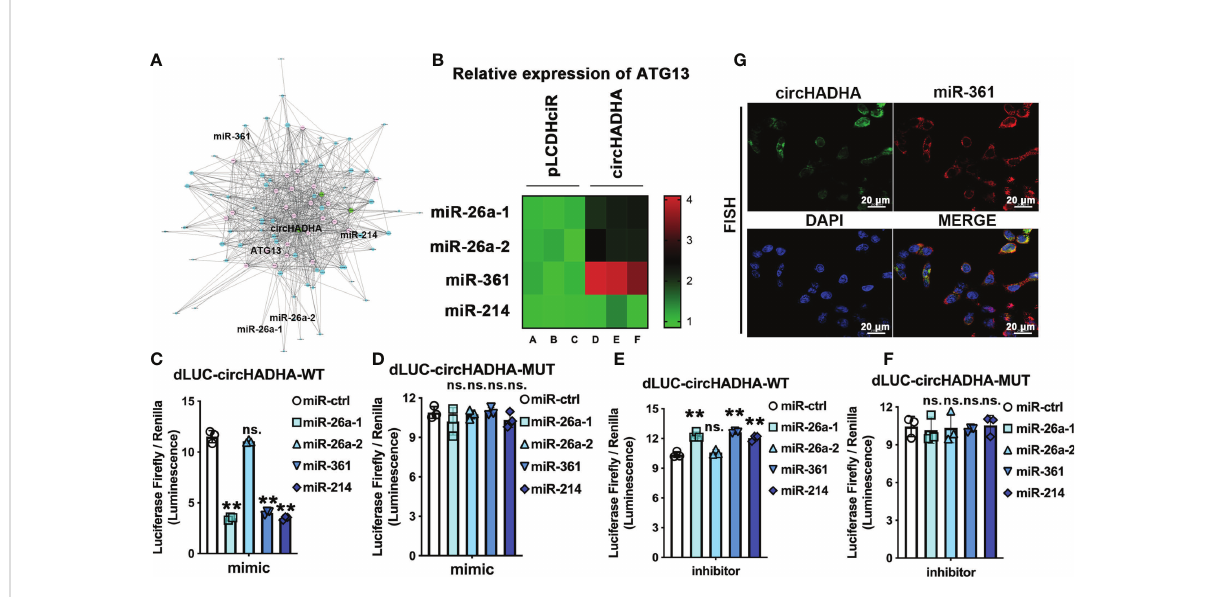
FIGURE 4 CircHADHA is a sponge that binds to miR-361 directly. (A) The potential binding candidates miR-26a-1, miR-26a-2, miR-361, miR-214, and ATG13 were predicted by ceRNA analysis for circHADHA to regulate autophagy. (B) The relative expression of ATG13 transfected by candidates miR-26a-1, miR-26a-2, miR-361, and miR-214 in HCoEpiC. miR-361 mediated the most signi fi cant increase of ATG13 expression with circHADHA overexpression compared to control in HCoEpiC. (C – F) The dual-luciferase reporter system with full-length and mutant circHADHA was generated. (C) Candidate miR-26a-1, miR-361, and miR-214 signi fi cantly decreased the luciferase reporter activities of full-length circHADHA with the transfection of miRNA mimics. (D) The miRNA candidates did not affect the luciferase reporter activities of mutant circHADHA with the transfection of miRNA mimics. (E) Candidate miR-26a-1, miR-361, and miR-214 signi fi cantly increased the luciferase reporter activities of full-length circHADHA with the transfection of miRNA inhibitors. (F) The miRNA candidates did not affect the luciferase reporter activities of mutant circHADHA with the transfection of miRNA inhibitors. (G) FISH assay demonstrated a colocalization of circHADHA and miR-361 in HCoEpiC. FITC represented circHADHA. Cy3 represented miR-361. Cell nuclei were labeled with DAPI. Three independent experiments were performed. ** P < 0.01; ns, no signi fi cant